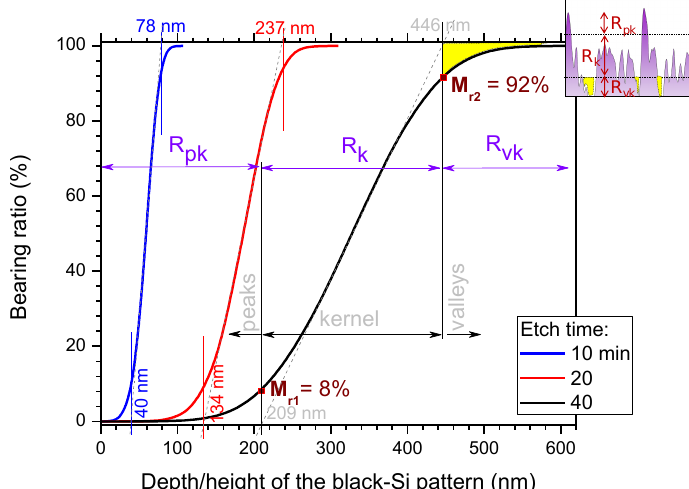
Figure A3. Bearing ratios of AFM traces (Figure 1b,c) of b-Si etched for 10, 20 and 40 min. See text for definitions of the parameters marked on the the Firestone–Abbott bearing curve (standards DIN4776; STN ISO 13 565-2). Inset illustrates schematically the peak, kernel, and valley extent on actual AFM profile of 40 min etched Black-Si; yellow area-mark corresponds to the air pockets in the b-Si pattern which have height (depth) extent of R vk .